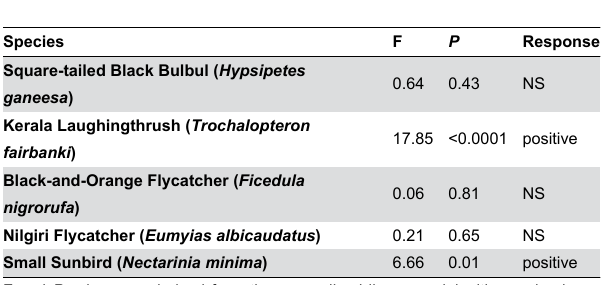
Table 2. Responses of Western Ghats endemic and threatened species to natural windbreaks.